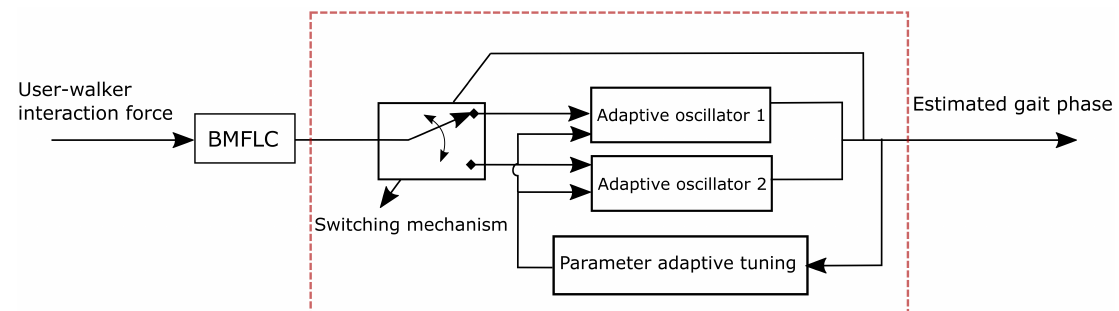
Figure 2. Architecture of proposed gait phase estimation